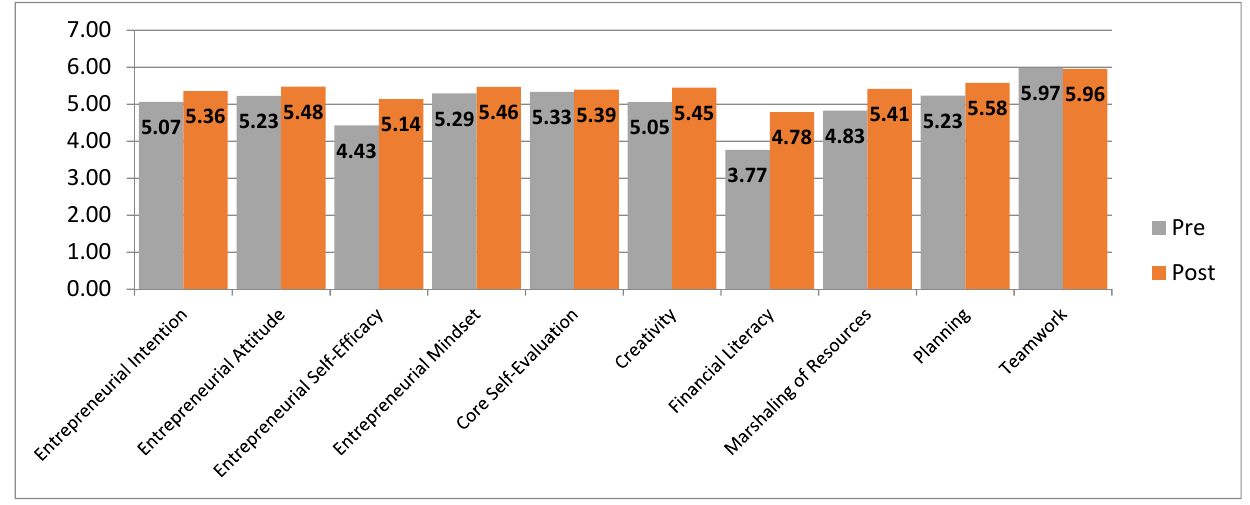
Figure 8. The average values of the entrepreneurial characteristics, pre- and post-course, of the students who worked on patented technologies.